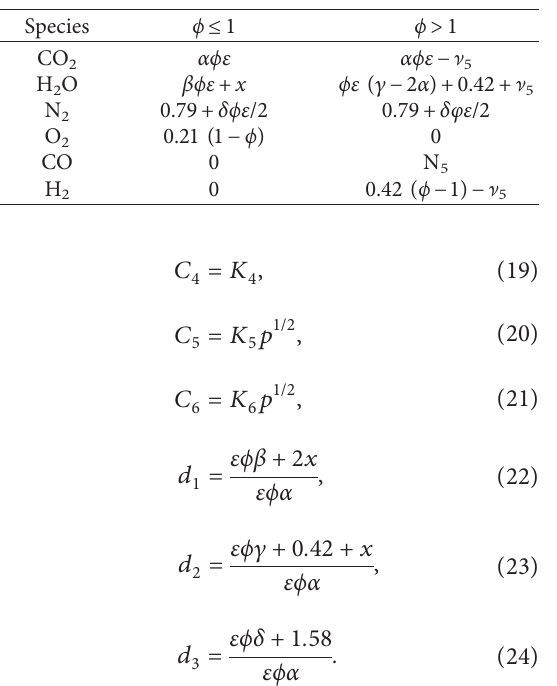
Table 2: Products of wet combustion for T <